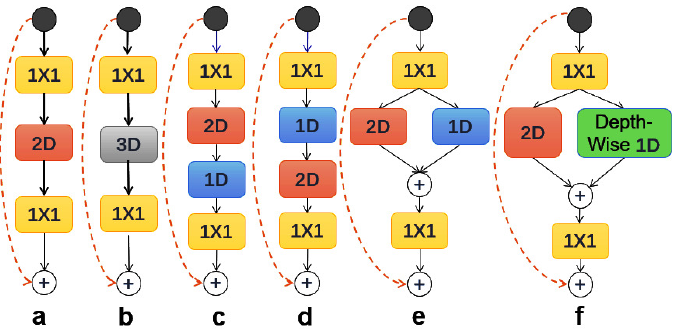
Figure 1. Typical spatial-temporal convolutional structures. ( a ) C2D; ( b ) C3D; ( c ) 3D; ( d ) reversed 3D; ( e ) parallel architecture; ( f )